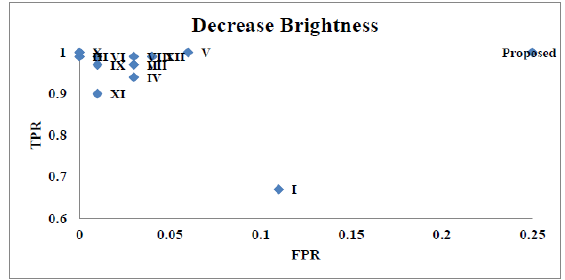
Figure 12. TPR vs. FPR: Decrease Brightness.